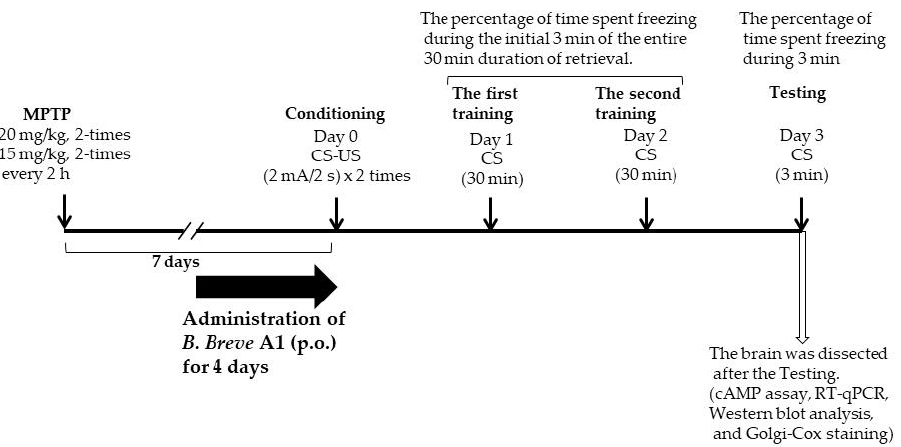
Figure 1. A schematic figure explaining the planning of the experiments. 2.4. RNA Extraction and Real-Time Quantitative Polymerase Chain Reaction (RT-qPCR)